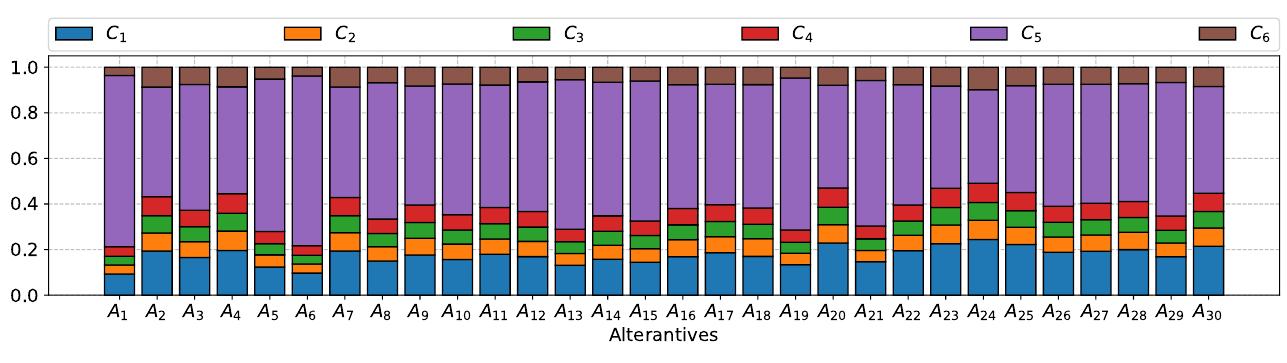
Figure 3. Local weights for individual alternatives for SPOTIS